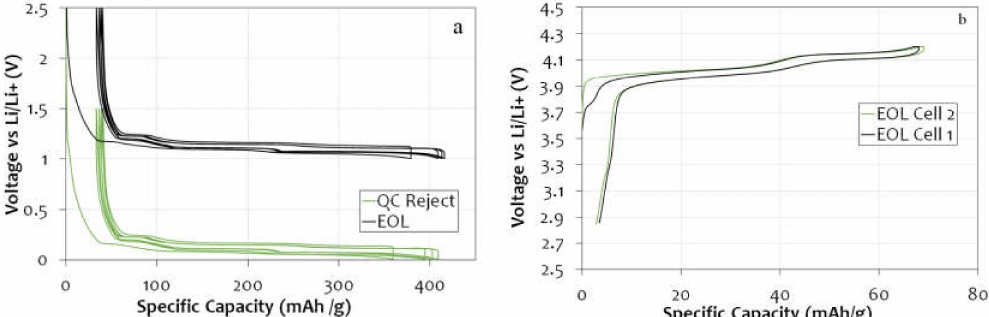
Figure 13. Formation cycle of the ( a ) anodes half-cells from QC reject and end of life anodes ( b ) and two cathode half-cells for end of life cathode after heat treatment of the reclaimed black